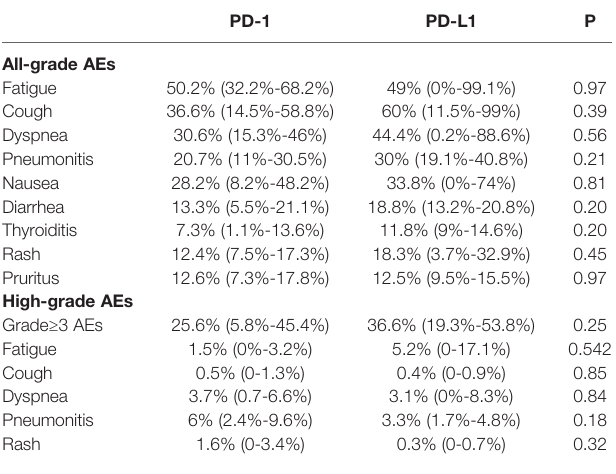
TABLE 4 | Difference in incidence of AEs with PD-1 vs PD-L1 inhibitors combined with thoracic radiotherapy.